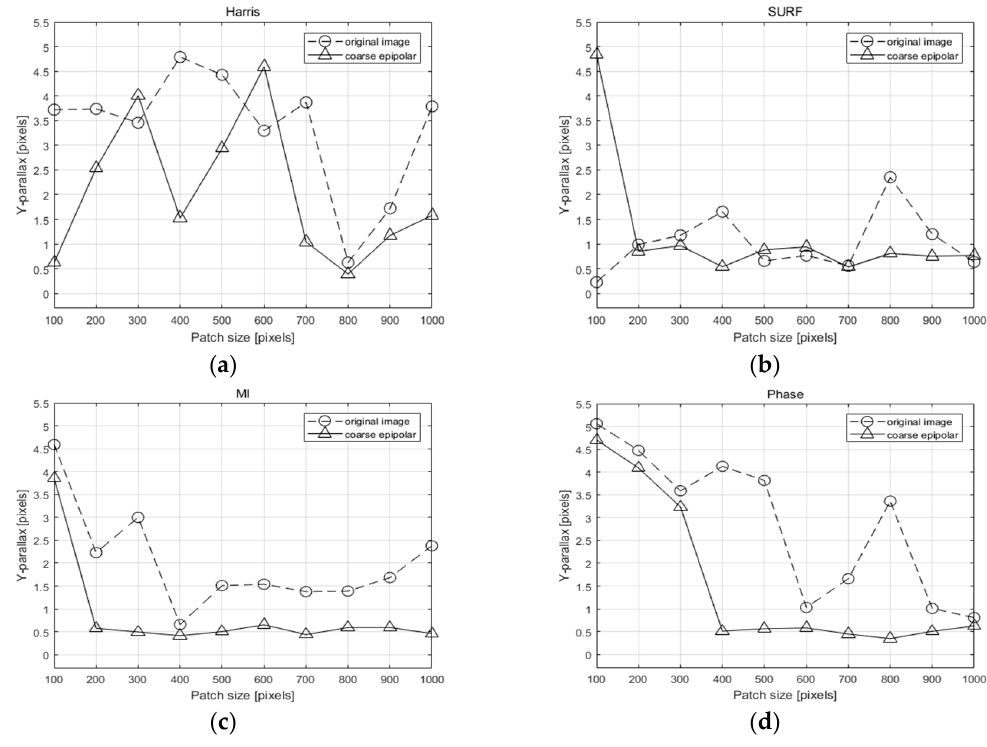
Figure 22. Y-parallax (along-track Kompsat-3): ( a ) HARRIS–FREAK ( b ) SURF, ( c ) MI, and ( d )